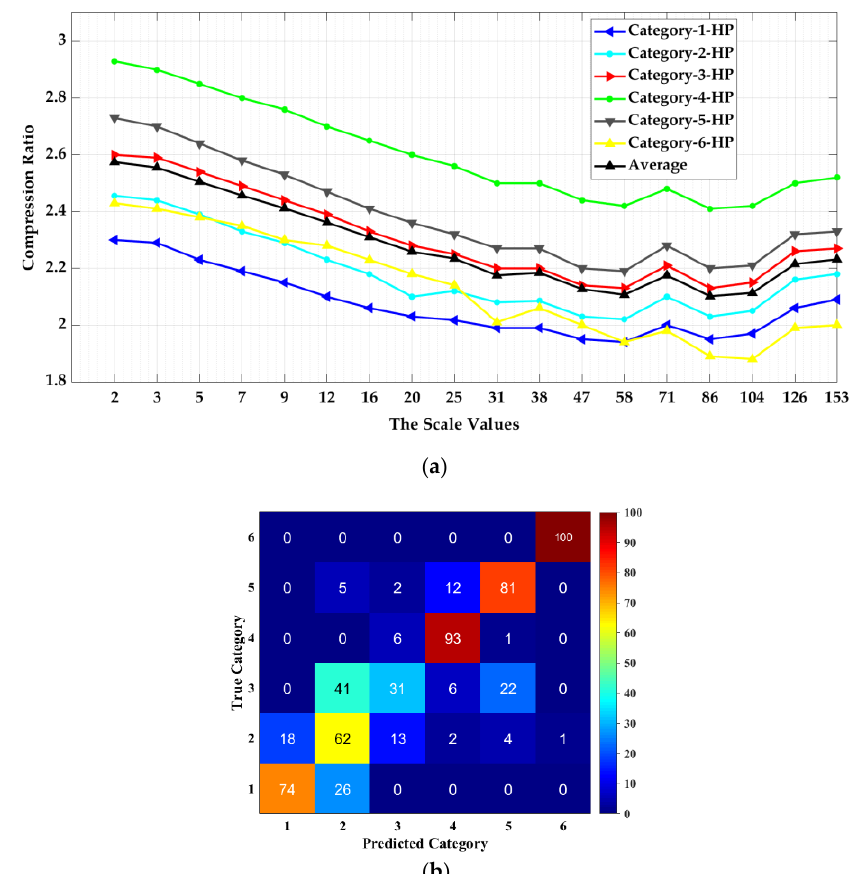
Figure 28. The impact of scale of analysis on the performances of a compressed-domain classifier: ( a ) the relation between the scale of analysis and the six surface categories’ compression and classification performances by using the multiscale HP data sets and ( b ) a confusion matrix for six surface categories classification by using 50% of the highest-scale HP data set for training.